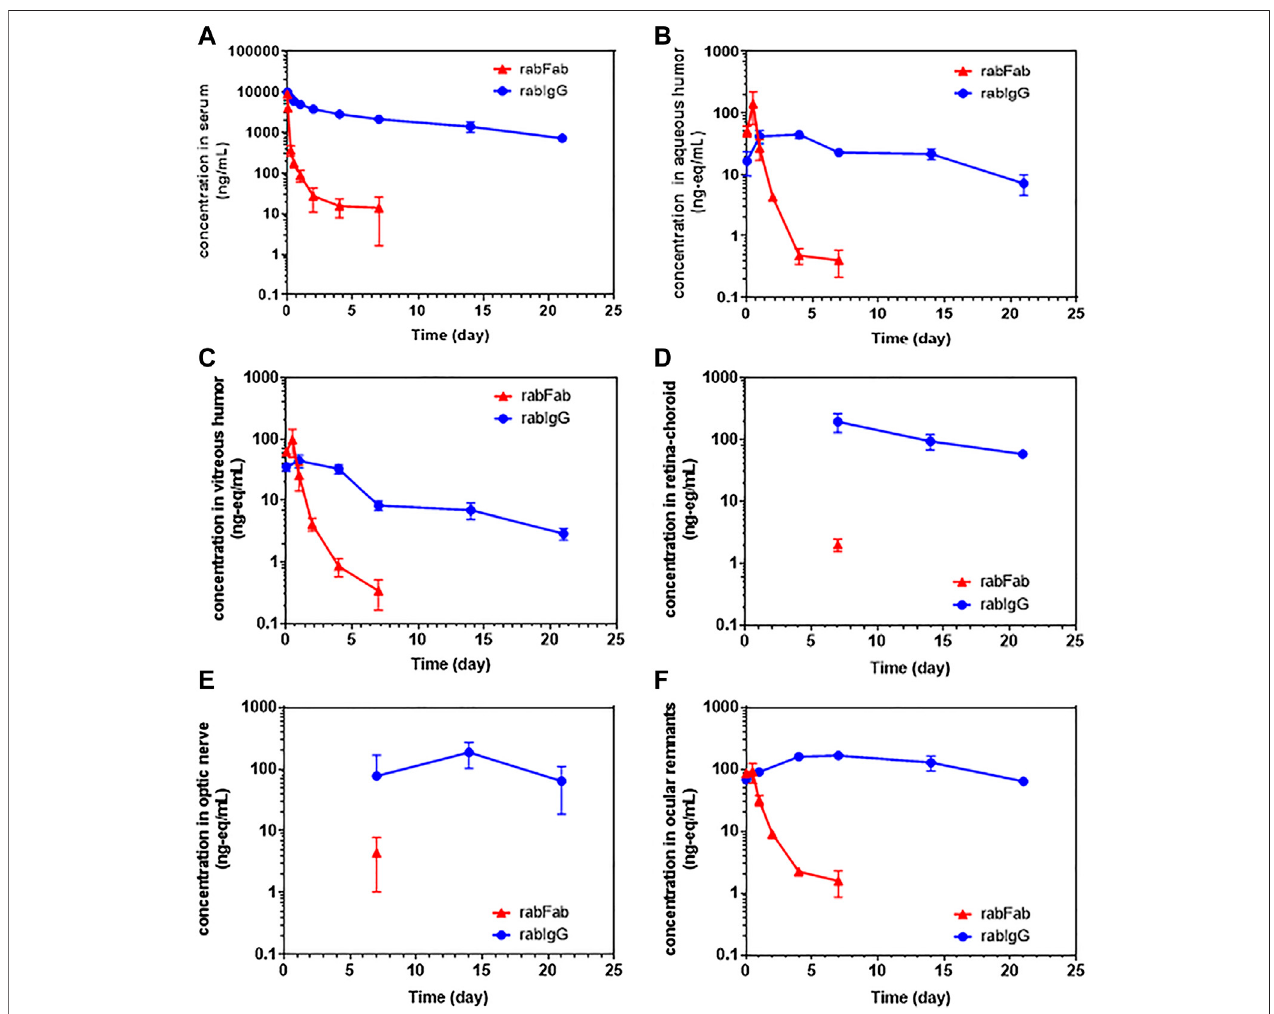
FIGURE 1 | The concentration – time pro fi les of rabFab and rabIgG in (A) serum (B) aqueous humor (C) vitreous humor (D) retina-choroid (E) optic nerve, and (F) ocular remnants following a single intravenous bolus administration of 125 I-rabFab or 125 I-rabIgG (radiolabeled mixed with unlabeled, total 1 mg dose) in male New Zealand White rabbits. Data presented are Mean ± SD. Data in panel (A) represent protein bound concentrations in serum reported as nanogram/milliliter (ng/mL) and data in all other tissues (panels B - F) represent total (protein bound plus catabolized 125 I) concentrations reported as nanogram-equivalents/milliliter (ng-eq/ mL). Concentrations in all matrices are reported in volume units and density of “ 1 ” assumed for all weight-based